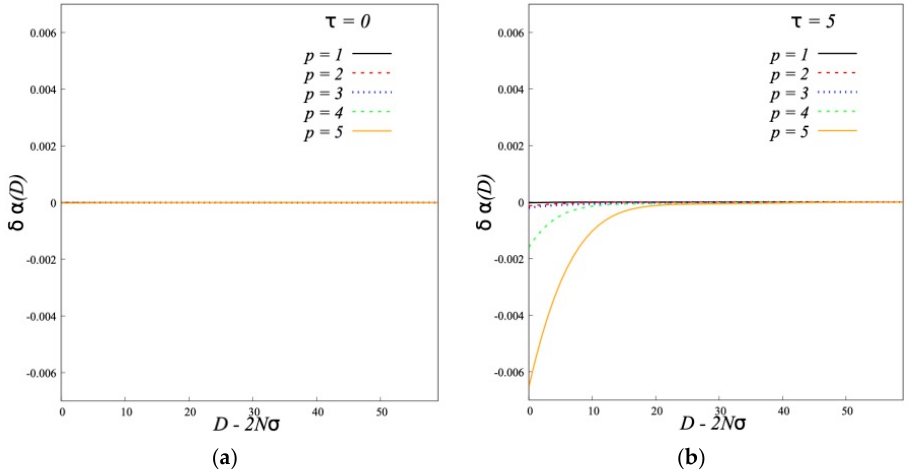
Figure 11. Change in first moment of polymer density distribution ( N = 200, σ = 0.3) at τ = 0 (a) and τ = 5 (b) .